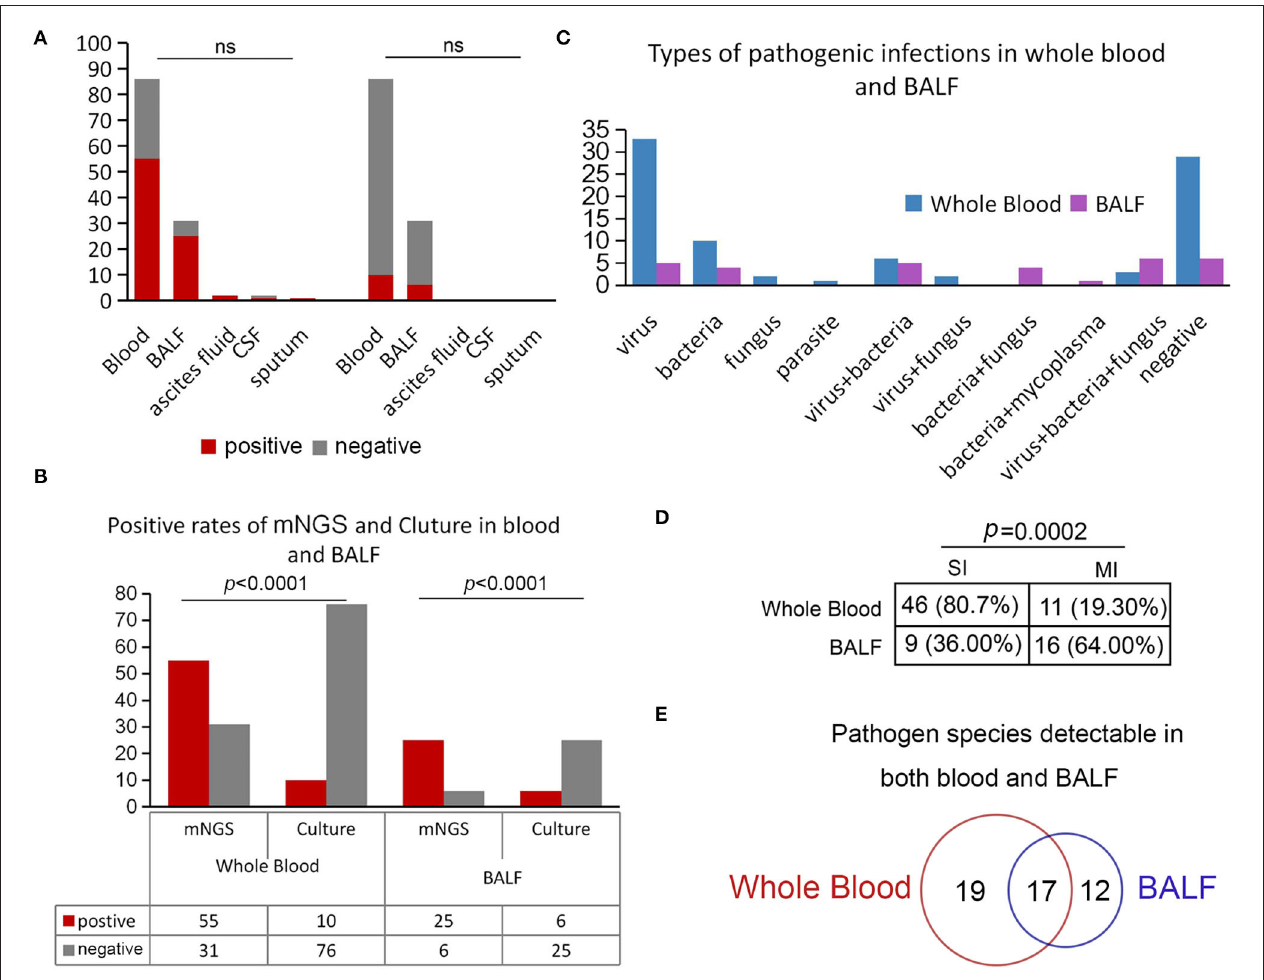
FIGURE 4 | Positivity rate comparison and concordance analysis between whole blood and BALF. (A) Comparison of the positive rates of mNGS and culture in different sample types. (B) Positive rates of mNGS and culture in blood and BALF. (C) Positive rates of mNGS and culture in whole blood and BALF. (D) Comparison of simple and mixed infections in whole blood and BALF. (E) Pathogen species detected in both whole blood and BALF.